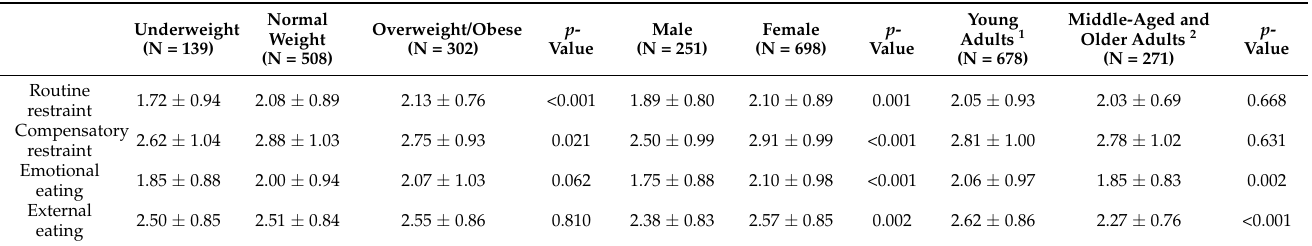
Table 2. The scores of psychological aspects of eating behaviors in individuals with different weight statuses, age and gender.